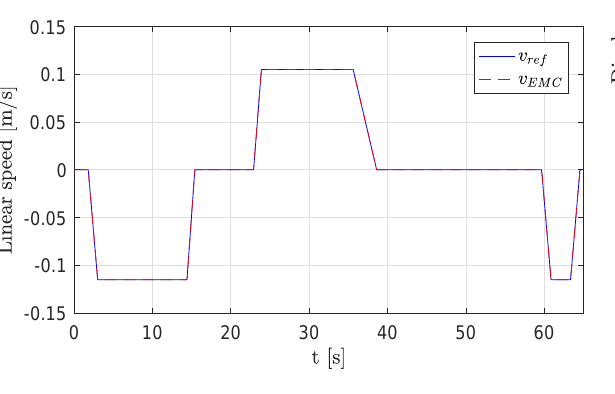
Figure 11: EMC drivetrain speed.